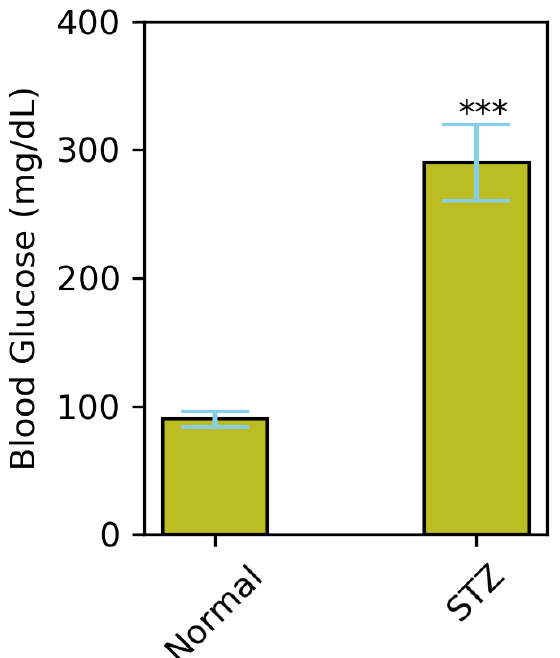
Figure 10. Average FBG levels (mmol/L) in control mice and mice fed with HFD from age of 3 to